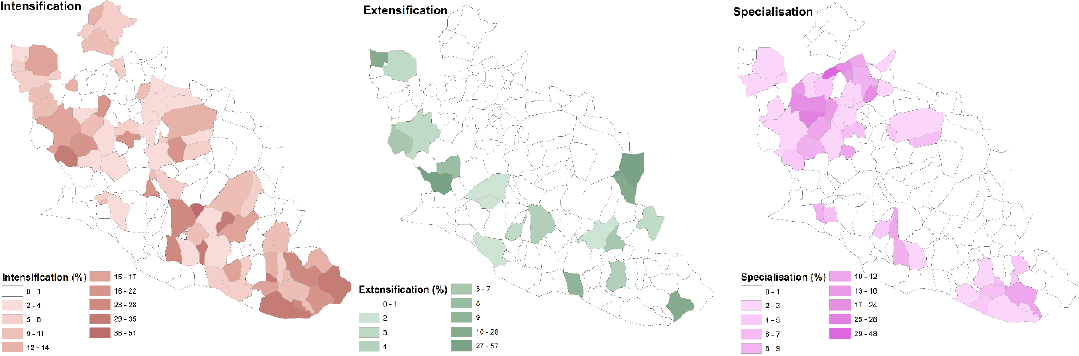
Figure 5. Intensification, extensification, and specialization trajectories on the Vaucluse department.